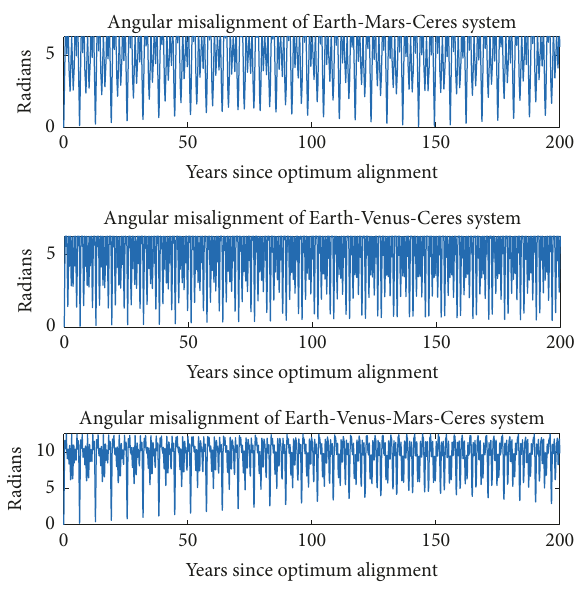
Figure 10: Illustration of the system misalignment from a presumed optimum at year